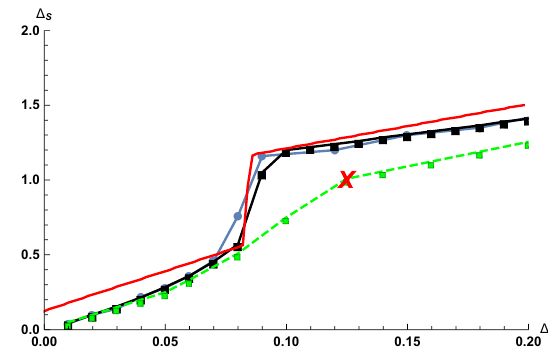
Figure 1. Plot of bounds on dimension of leading scalar in the OPE of (cid:30) (cid:2) (cid:30) for d = 2 using linear programming, keeping only scalars in the spectrum in the diagonal limit. The blue line is for 10 derivatives in the functional while the black is for 20 derivatives. In each case truncating the spectrum does not change the plot much. The green line is obtained in the non-diagonal limit [7], including spins, while the red cross is the location of the 2d Ising model. The red line indicates what arises from considering the intersection of the N = 2 cyclic polytope obtained using scalars in d = 2 and the crossing